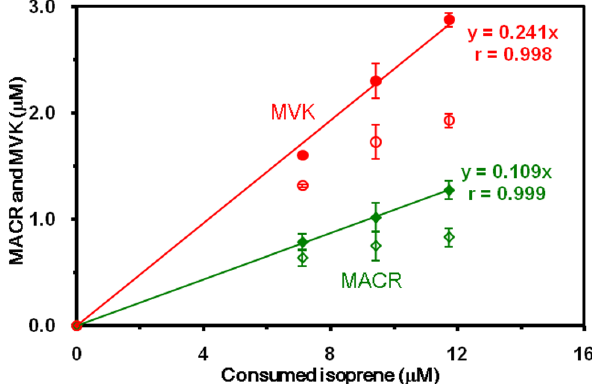
Fig. 2. The amounts of methacrolein (MACR) and methyl vinyl ketone (MVK), formed compared to the isoprene consumed in an aqueous isoprene oxidation. Samples were measured at 10, 15, and 20min from the beginning of the reaction. Open symbols are the observed concentrations; solid symbols and fits are the concentra- tions after correcting for loss due to a reaction with OH, based on the rate constants determined in this